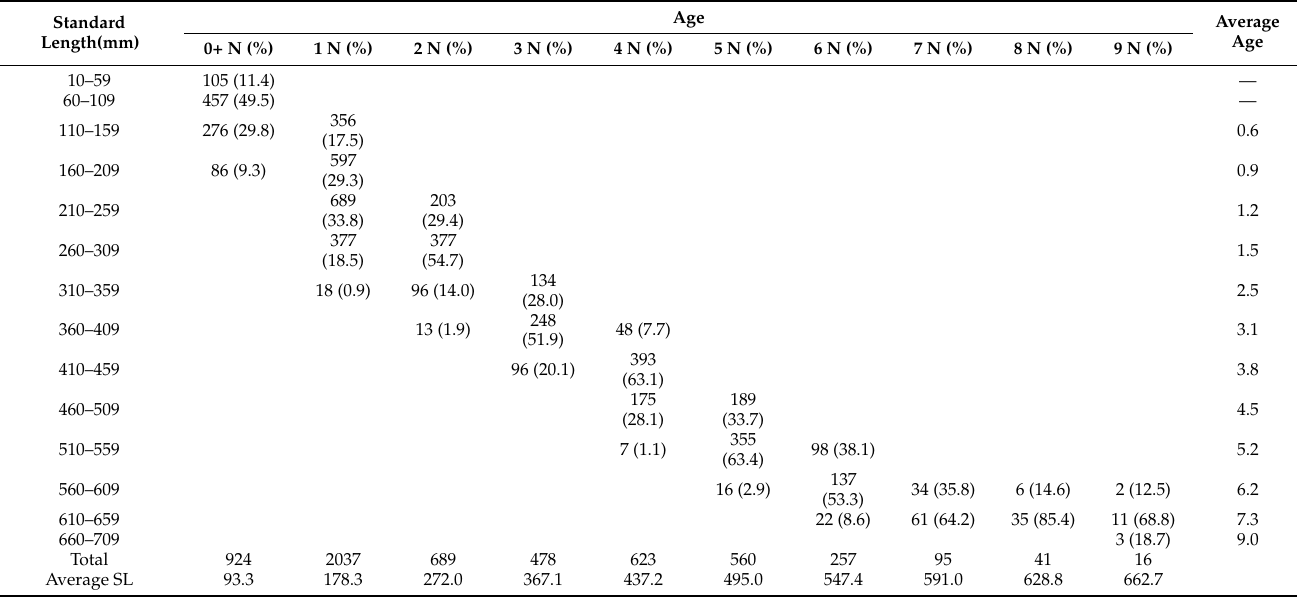
Table 3. Standard length-age comparison table of the Silver Carp population.